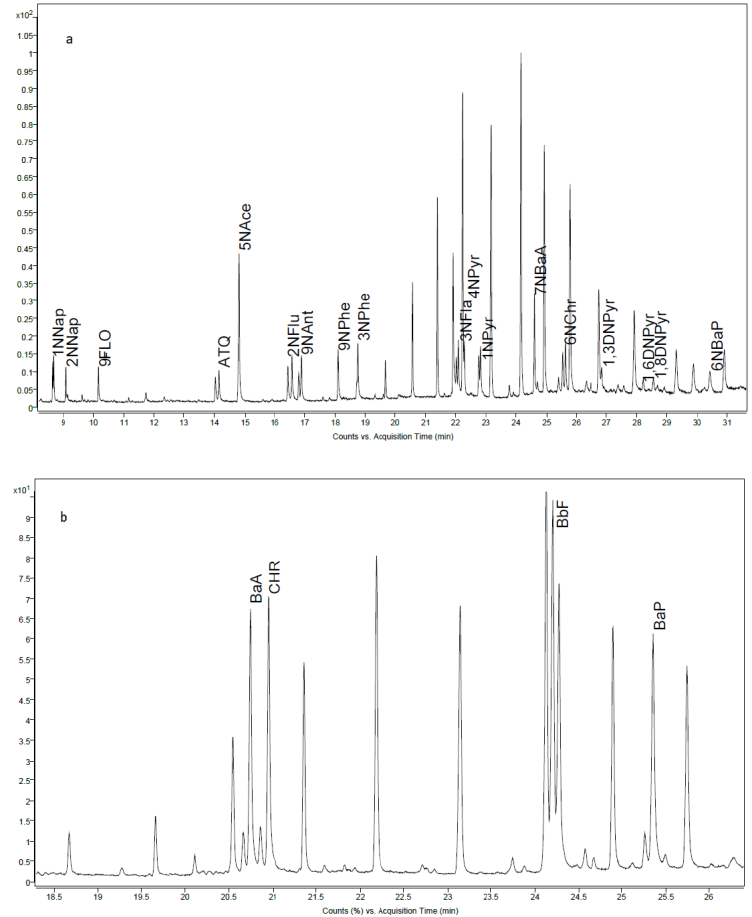
Figure 2. Chromatograms of standards (500 ng/mL) with quantified compounds labelled with corresponding compound name ( a ) NPAHs and OPAHs ( b ) PAH4. Table 2. Analysed compounds with retention times and m / z -values for quantification with the in-